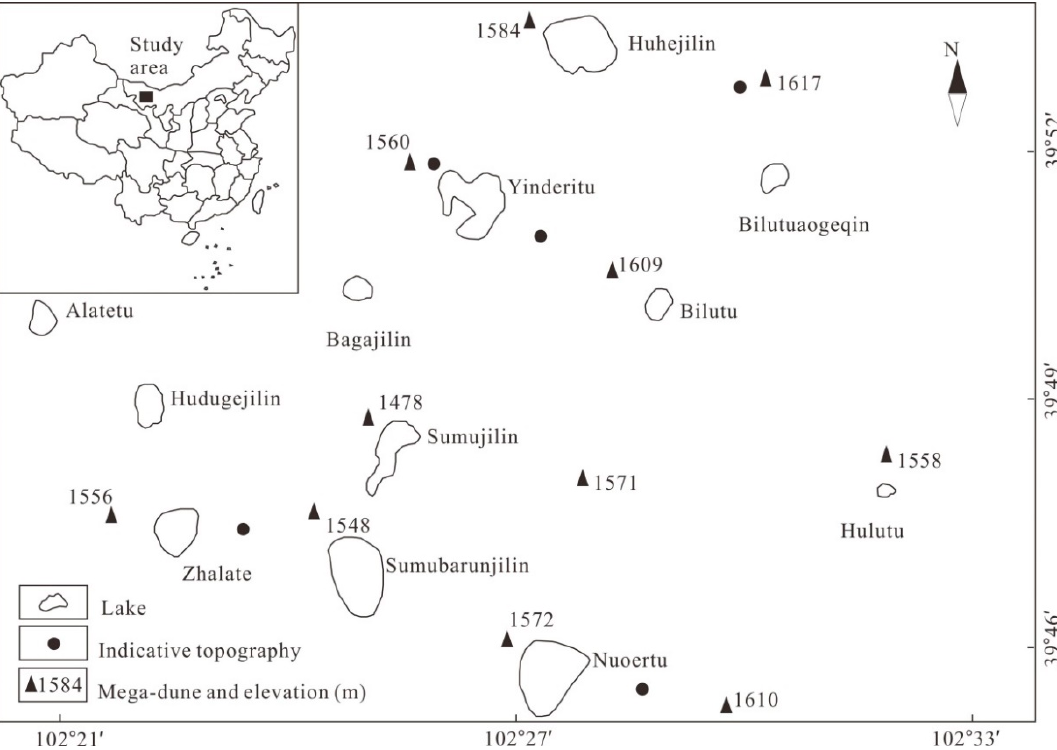
Figure 1. Location of the study area and sites of the studied multi-stage fans in the Badain Jaran Desert.